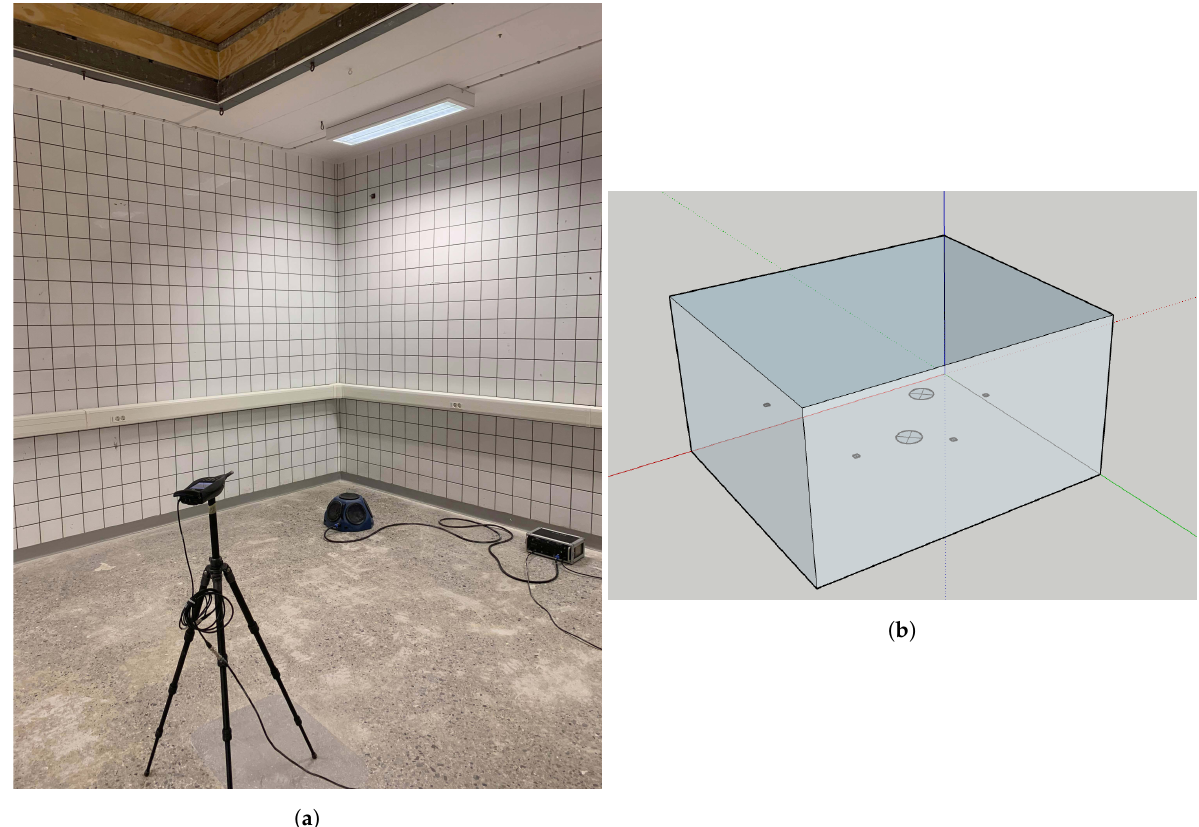
Figure 2. ( a ) Photo and ( b ) model of the space used for measurements and simulation. Two speaker positions and four microphone positions are marked in ( b